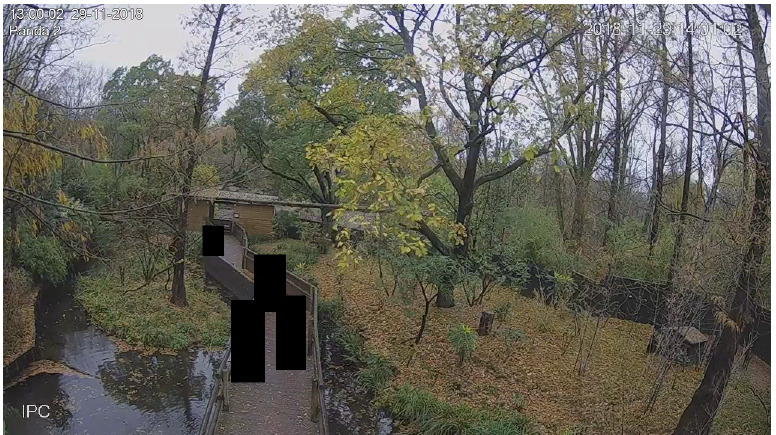
Fig 1. An overview of the red panda enclosure during the observation period. The indoor exhibit cannot be seen, but is situated in the below-right corner. A red panda can be seen in the tree on the left. Black squares are placed upon people that may otherwise have been recognizable.